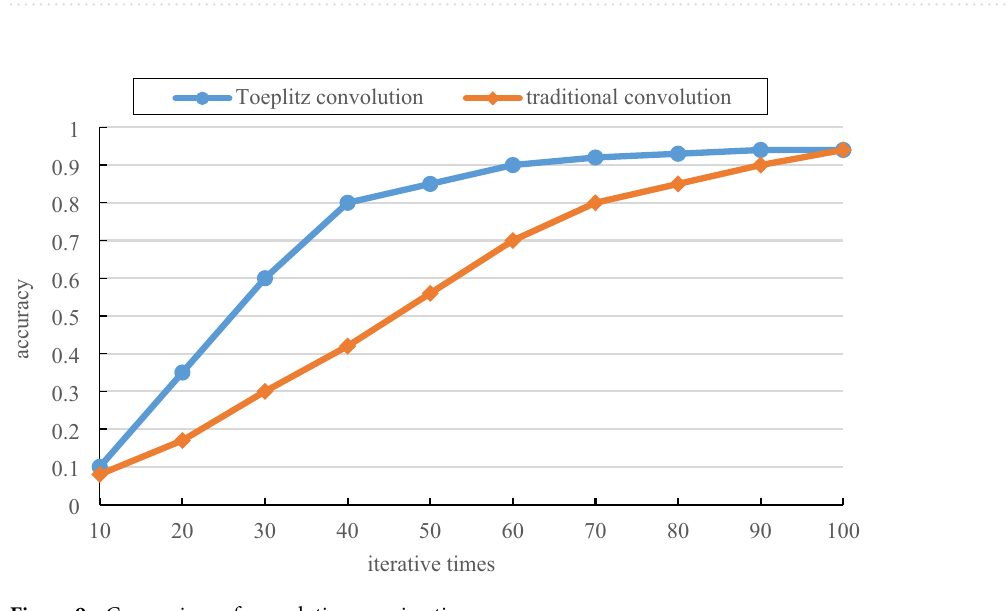
Figure 9. Comparison of convolution running